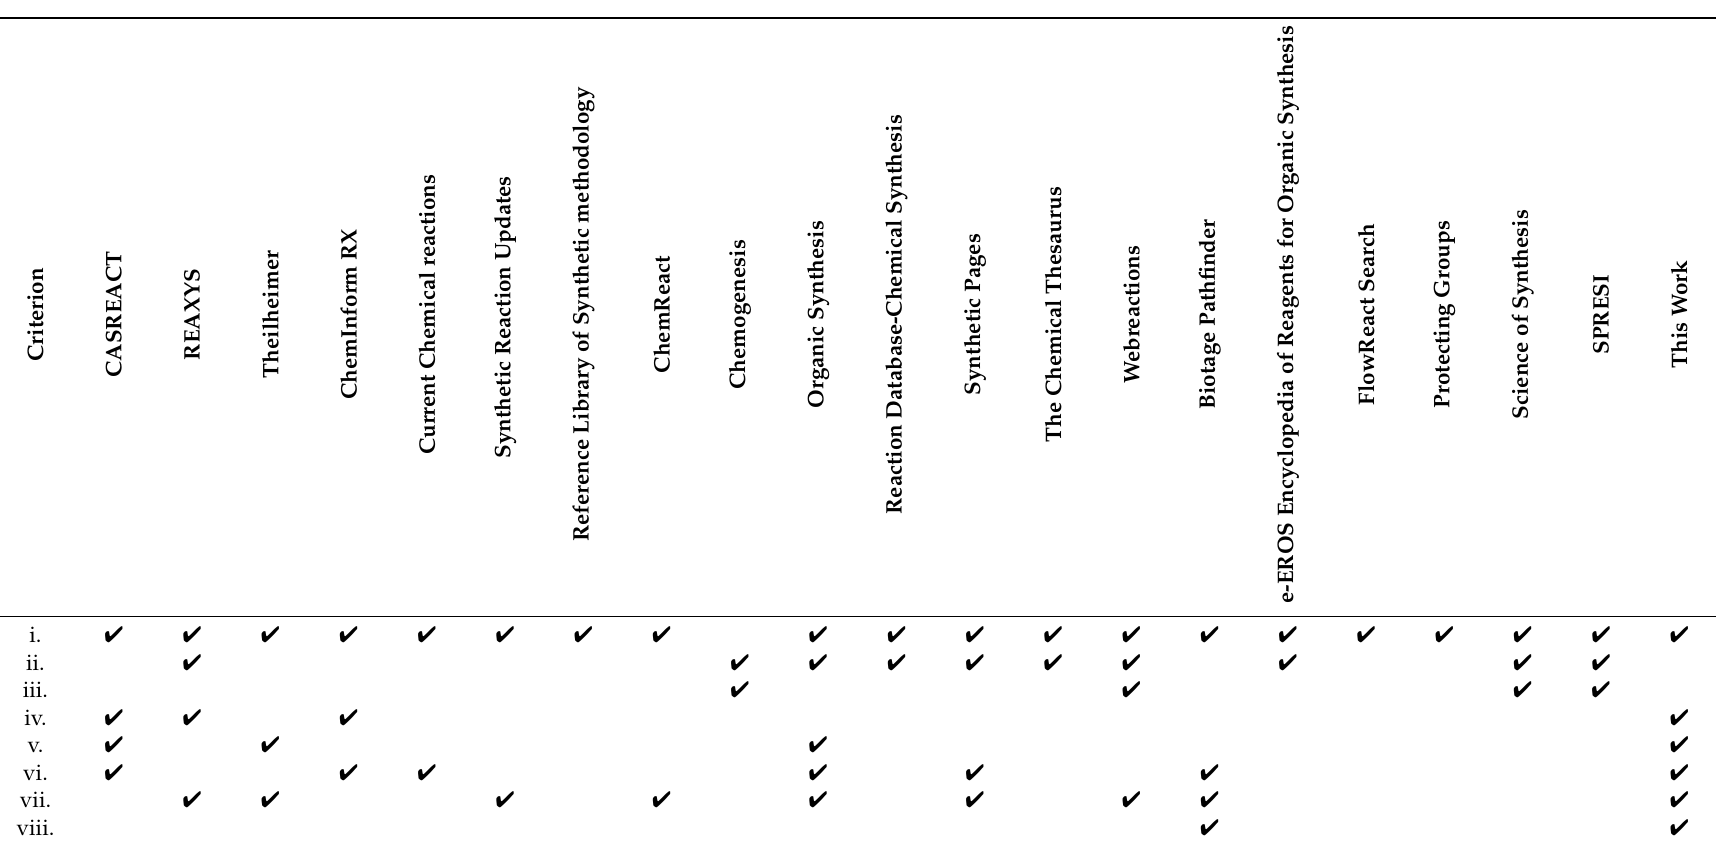
Table 3. List of available databases and the criteria [17] they fulfill. Criterion: (i) individual records of reactions, (ii) chemical structure information, (iii)